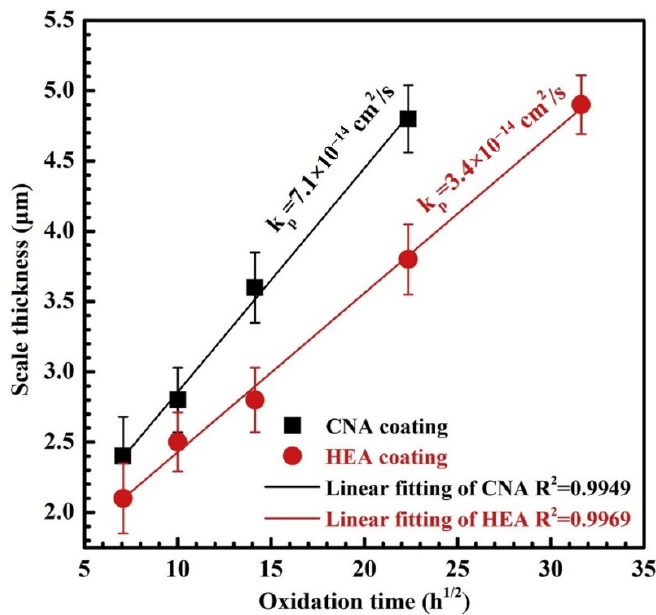
Figure 18. Oxide scale evolution for two coating types at 1100 °C as a function of the square root of oxidation time. Oxide scale thickness on the CNA coating was merely measured until 500 h oxidation. Reprinted with permission from [28] Copyright 2021 Elsevier.